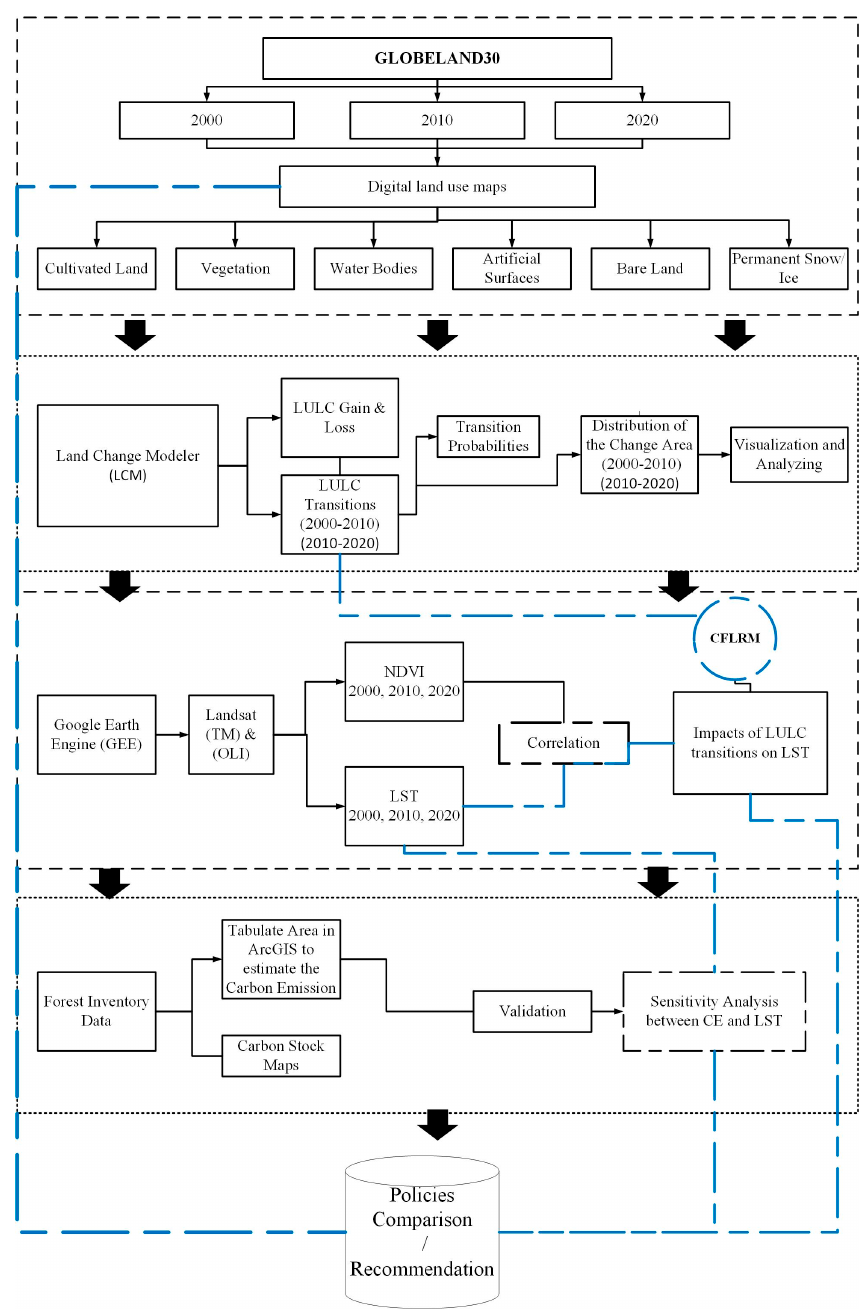
Figure 2. Flowchart indicating the detailed procedures for data collection, preprocessing, and evaluation of results.